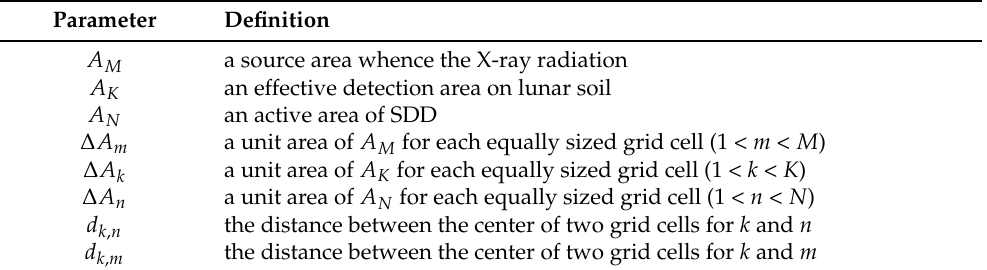
Table 7. Definitions of geometrical parameters of